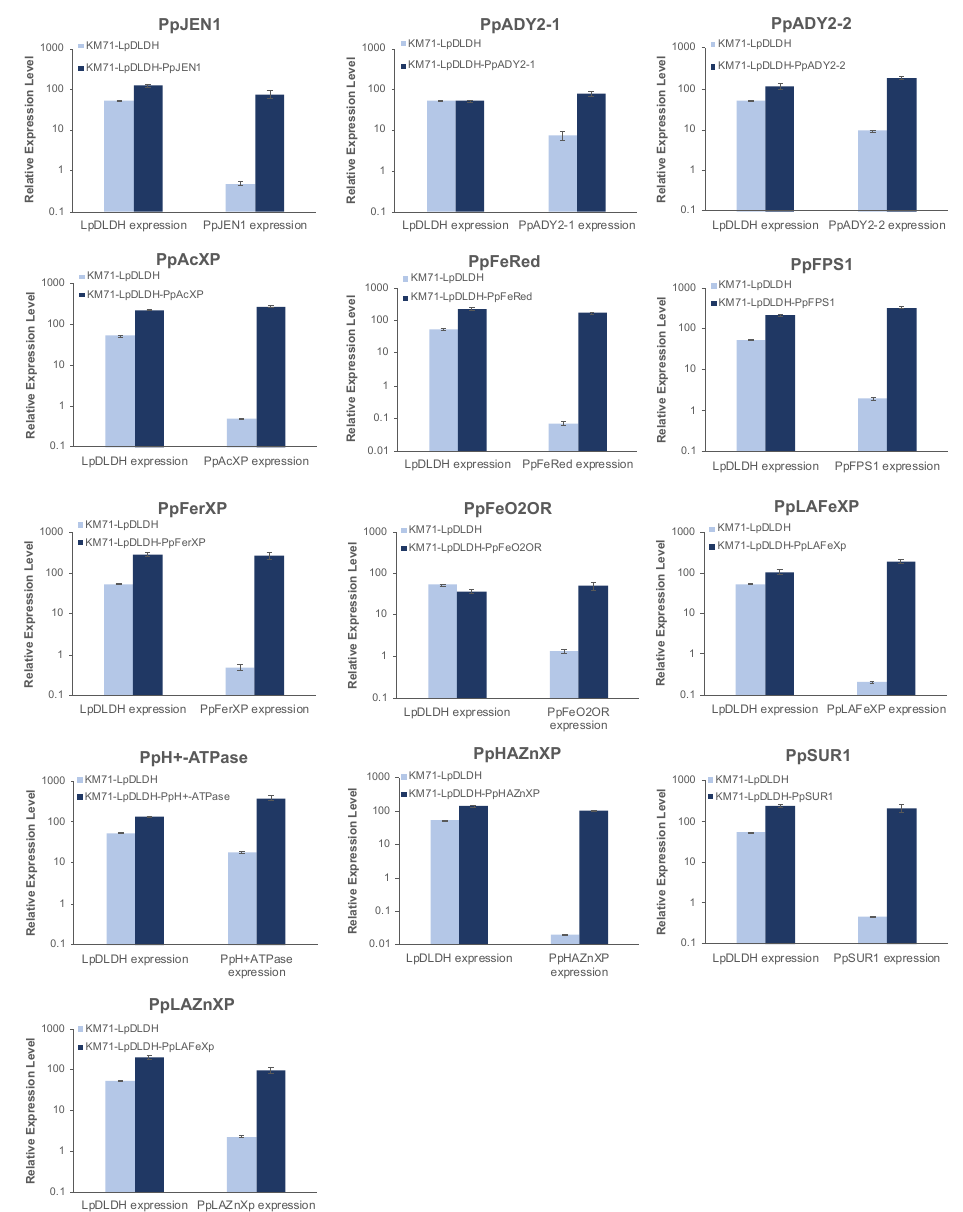
Figure 8. RT-PCR analysis of selected DE genes including PpJEN1 , PpADY2-1 , PpADY2-2 , PpFeRed , PpAcXP , PpLAZnXp , PpHAZnXP , PpFPS1 , PpFerXP , PpSUR1 , PpH + ATPase , PpFeO2OR , PpLAFeXp , and LpDLDH in engineered yeast. Real-time PCR was performed in three biological replicates. Values represent the mean of three biological replicates ± standard deviation ( n = 3).